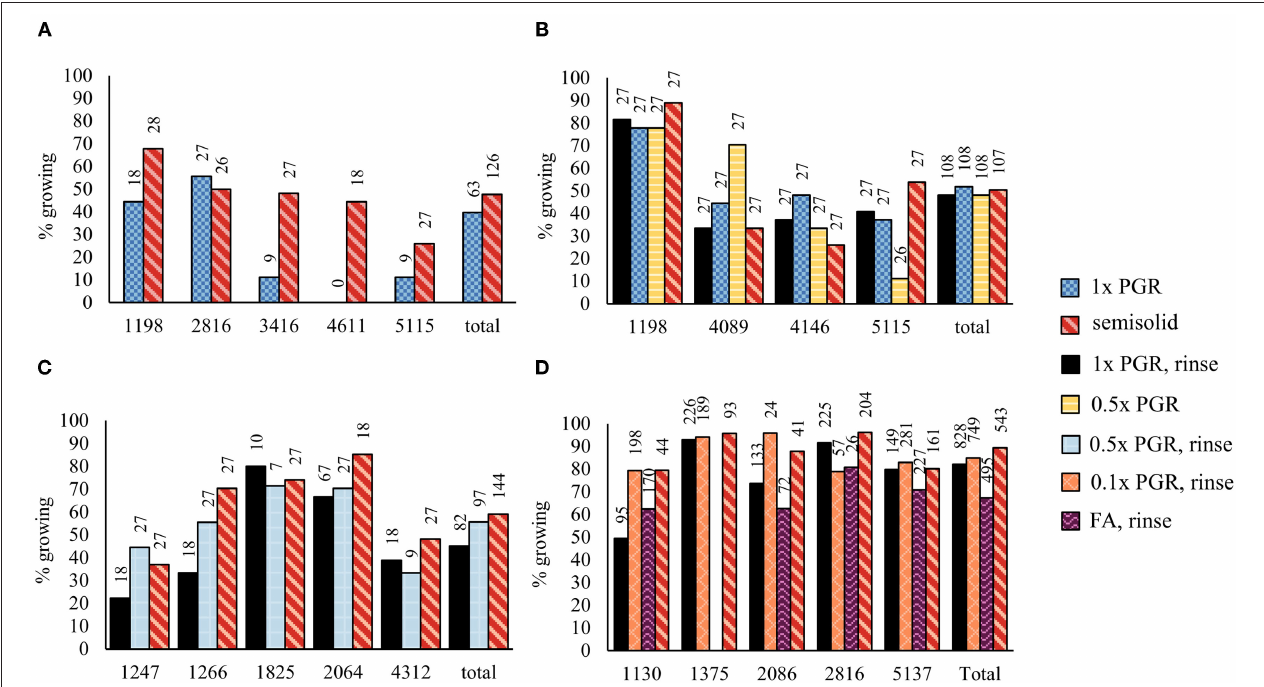
FIGURE 5 | Survival of emblings from Experiments I (A) , II (B) , and III (C) transplanted in July 2020 and Experiment IV (D) transplanted in July 2021. The survival in the greenhouse was evaluated 41 d and 42 d after transplantation in 2020 and 2021 respectively. 1x PGR, 0.5x PGR, and 0.1x PGR stand for the concentrations of plant growth regulators 2,4-D and BA in suspension cultures. The numbers at the end of the bars represent the number of embryos transplanted. The results of Experiment IV were analyzed with logistic regression presented in Table 2